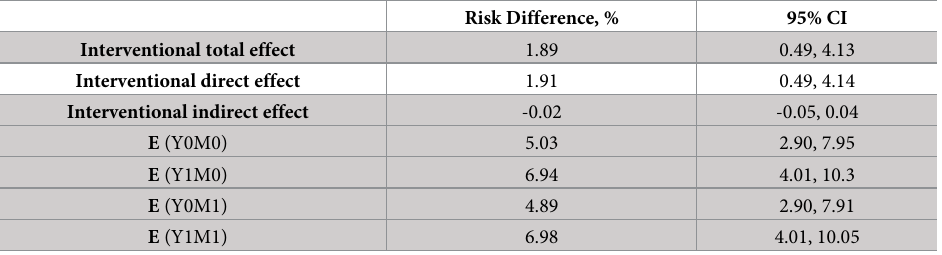
CHD: coronary heart disease, CI: confidence